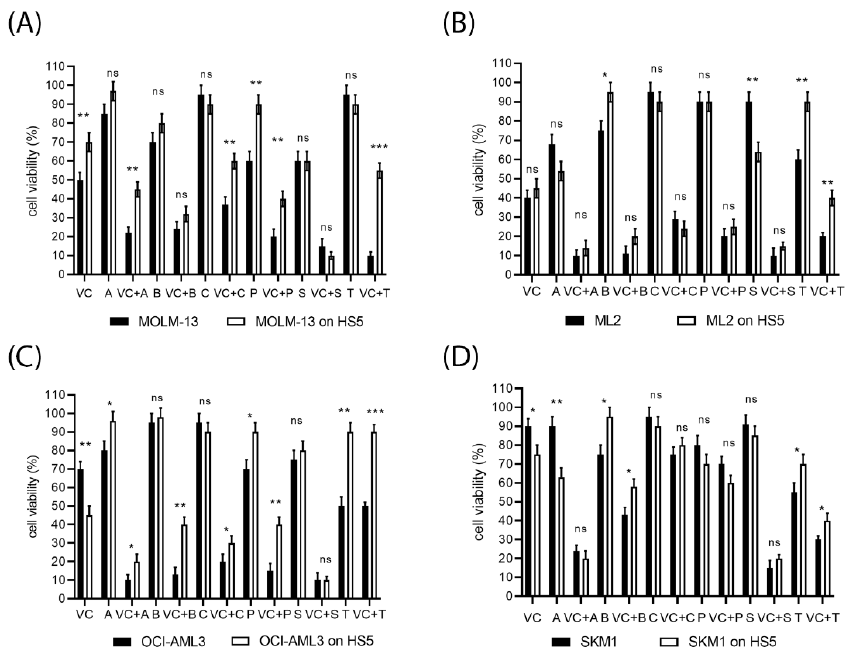
Figure 3. Susceptibility of AML cell lines to targeted therapies in the presence of bone marrow stroma. MOLM-13 ( A ), ML-2 ( B ), OCI-AML3 ( C ), and SKM-1 cells ( D ) were treated for 20 h with single compounds and in combination with venetoclax (VC), A1331825 (A), bimiralisib (B), C-188-9 (C), PTC596 (P), S63845 (S), or trametinib (T). Cell viability was determined in AML cells grown in the absence or presence of HS-5 stroma. Concentrations of inhibitors were 100 nM for venetoclax, S63845, PTC596 and trametinib, 1 µ M for bimiralisib, C-188-9, and A133825. Significance was calculated in a graph pad prism using grouped analysis with multiple unpaired t -test comparing cell viabilities of treated cells grown in the absence or presence of HS-5 stroma. Significance denoted for p < 0.05 (*); p < 0.005 (**); p < 0.0005 (***); no significance denoted for p > 0.05 (ns). A significance level of 0.05 indicates a 5% risk of concluding that a difference exists when there is no actual difference. 2.4. Venetoclax Combination Treatment Induces Cell Cycle Arrest, Apoptosis and Cell Death